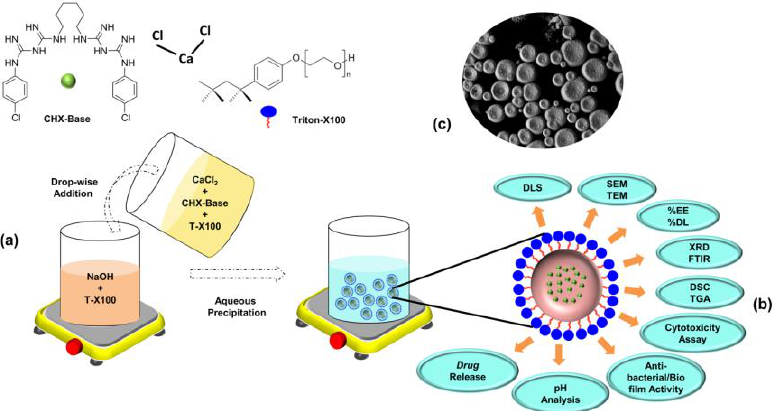
Figure 1. ( a ) Schematic illustration showing the synthesis and recovery of CHX-loaded/Ca(OH) 2 microparticles by modified aqueous chemical-precipitation method. The aqueous solutions containing 0.3 mol/L of CaCl 2 · 2H 2 O and 0.6 mol/L of NaOH were prepared separately with the supplementation of 0.15% of Triton X-100 to both the above formulated initial solutions. Different amounts of 25 and 50 mg of chlorhexidine (CHX) was added to the prepared CaCl 2 · 2H 2 O solution, blended well and